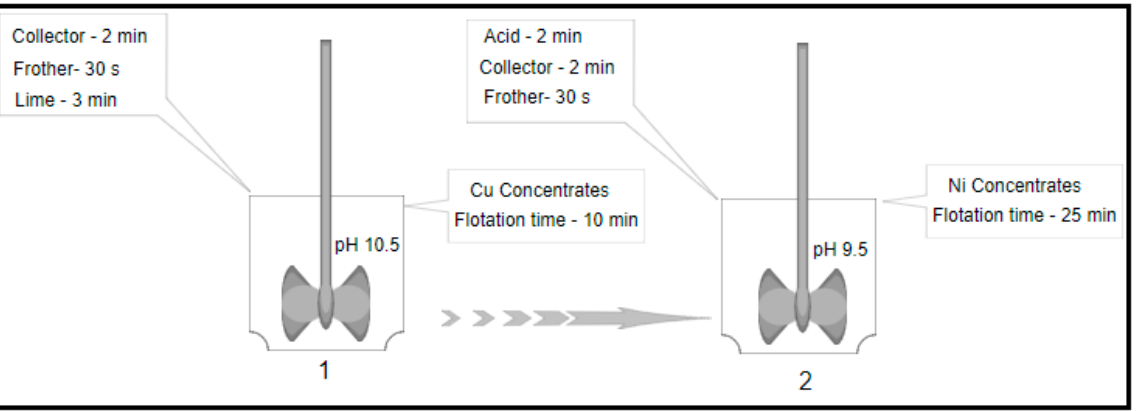
Figure 1. Sketch of the experimental setup used for laboratory flotation